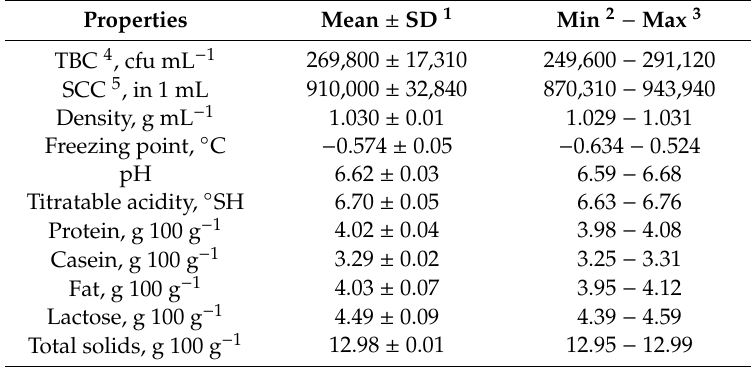
Table 1. Composition and physicochemical characteristic of raw goat’s